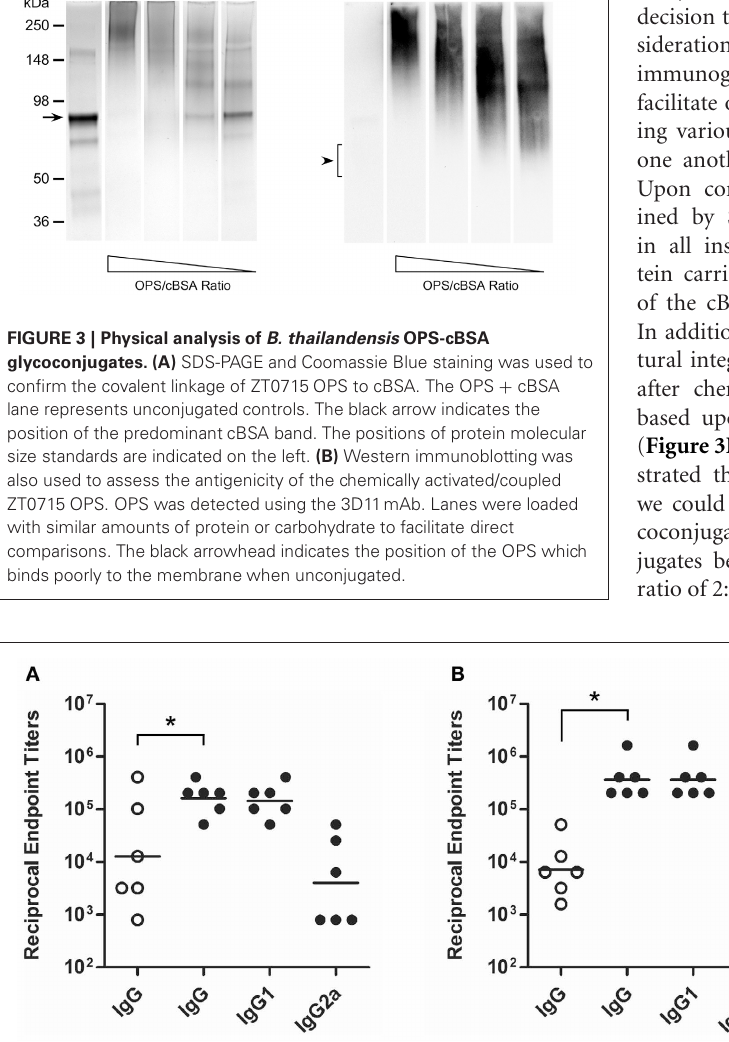
circles). The OPS1B1 and control samples were formulated with (A) saline, (B) saline plus Alhydrogel or (C) saline plus Alhydrogel/CpG prior to immunization. Individual symbols represent single mouse while the black horizontal bars indicate geometric means. ∗ P < 0 .